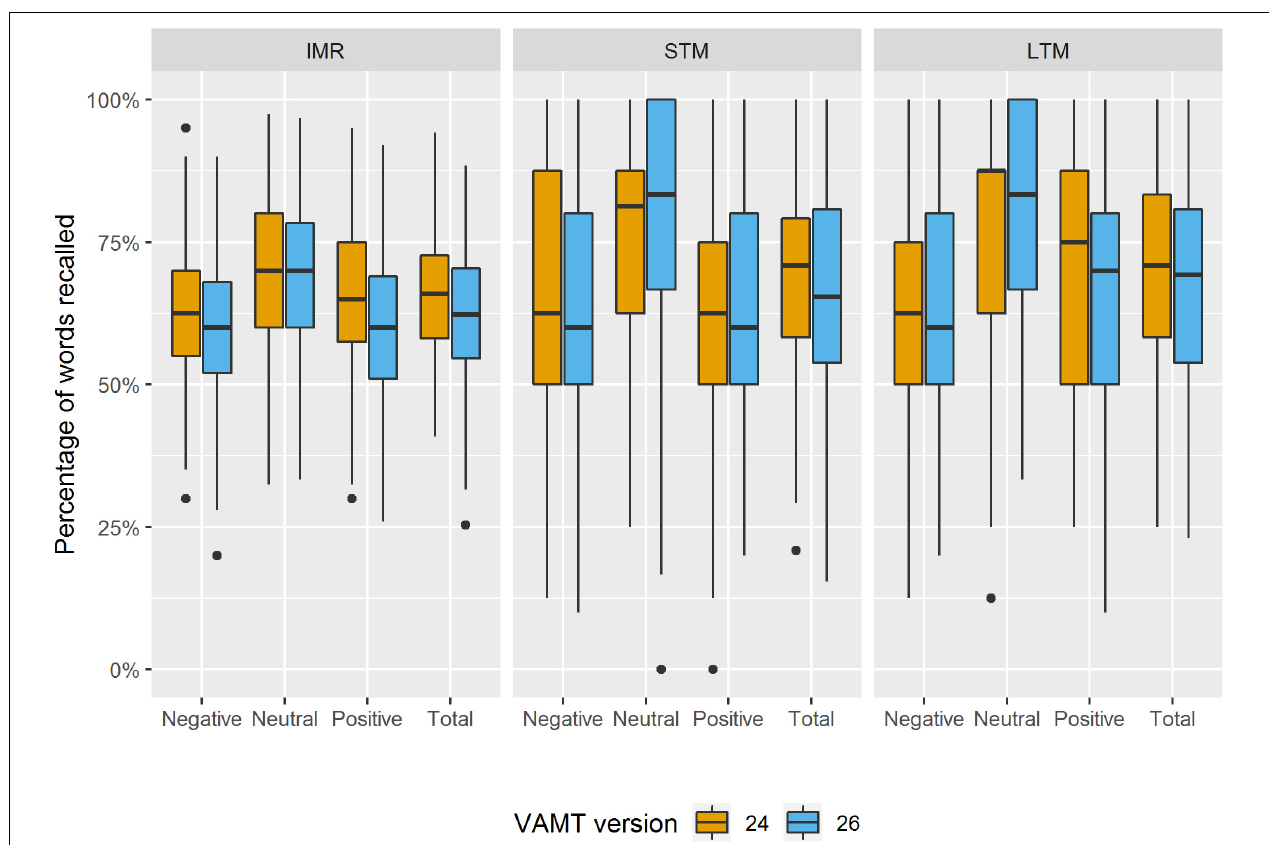
FIGURE 4 | Boxplots of distribution of the percentage of VAMT-24 and VAMT-26 recall outcomes. The boxplots show the distribution of the percentage of words recalled in total and within each valence (i.e., Positive, Negative, and Neutral) across the IMR trials 1–5, the STM trial and the LTM trial for VAMT-24 and VAMT-26, respectively. Outliers are identified as scores that fall below first quartile – 1.5 × IQR or above third quartile + 1.5 × IQR. Outliers are plotted as individual points.